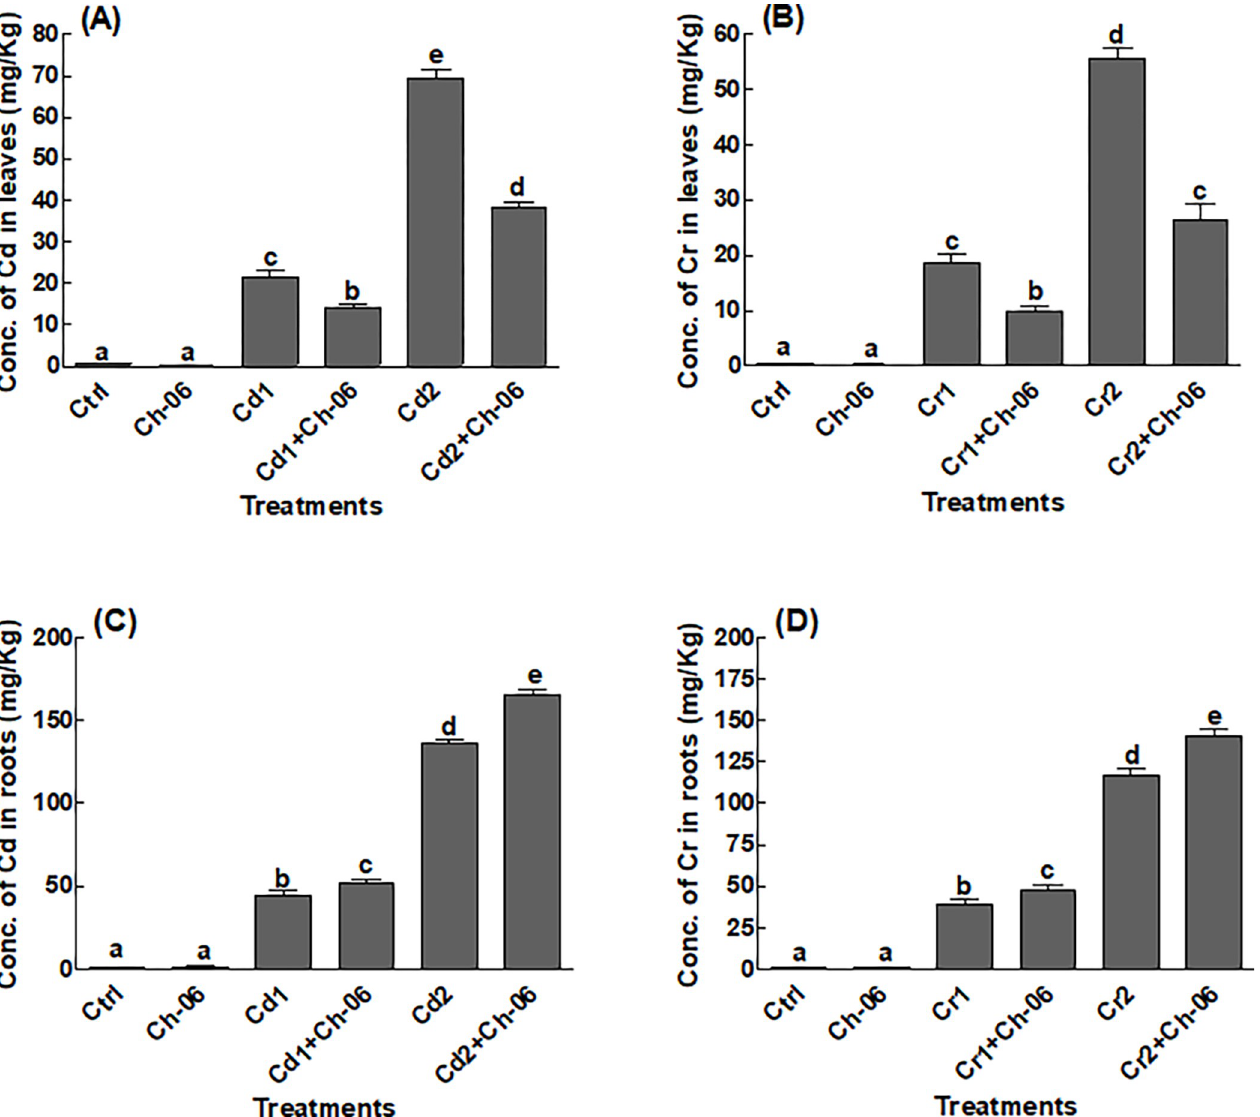
Fig 4. Impact of Ch-06 ( A . violaceofuscus ) on endogenous Cd and Cr content under elevated Cd and Cr stress. Cd = cadmium, Cr = chromium, Cd1 and Cr1 = 100 μ g/g, Cd2 and Cr2 = 500 μ g/g. (A): Cd or Cr concentration in okra leaves; (B): Cd or Cr concentration in okra roots. The data reflect the mean of triplicated data followed by ± SE. The data with different superscript letter are significantly different at P = 0.05.